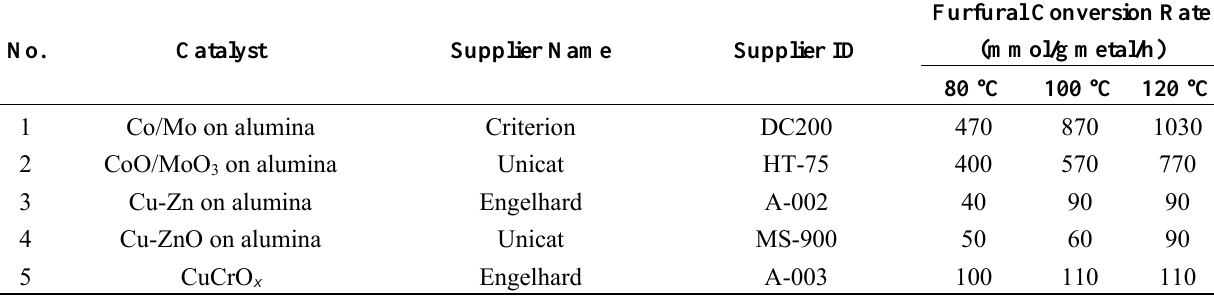
Table 1. Supplier specification and conversion rate of furfural (mmol/g metal/h) for each catalyst tested in the reductive etherification of furfural. “Pre-red” indicates catalysts already present in a “pre-reduced”